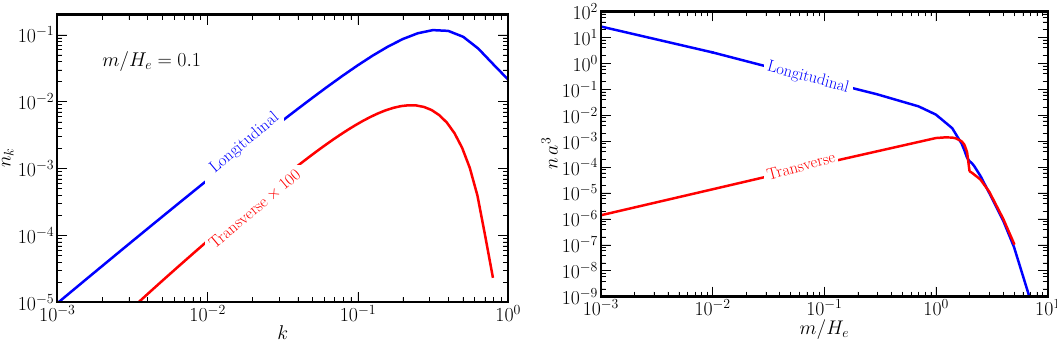
Figure 3 . Left panel: Numerical results for the spectrum of gravitationally-produced particles in the chaotic model for massive vector fields assuming m/H e = 0 . 1 . (Note that the transverse mode has been multiplied by a factor of 10 2 .) Recall that k = k/a e H e , n k = n k /a 3 and we set a e H e = 1